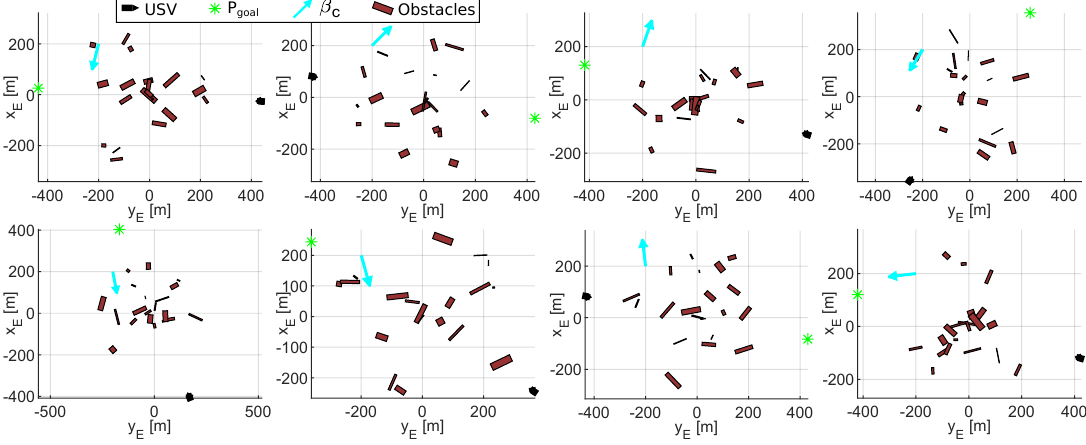
Figure 4. Random sample of obstacle scenarios, where Θ E = ( 8 20 300 75 25 )